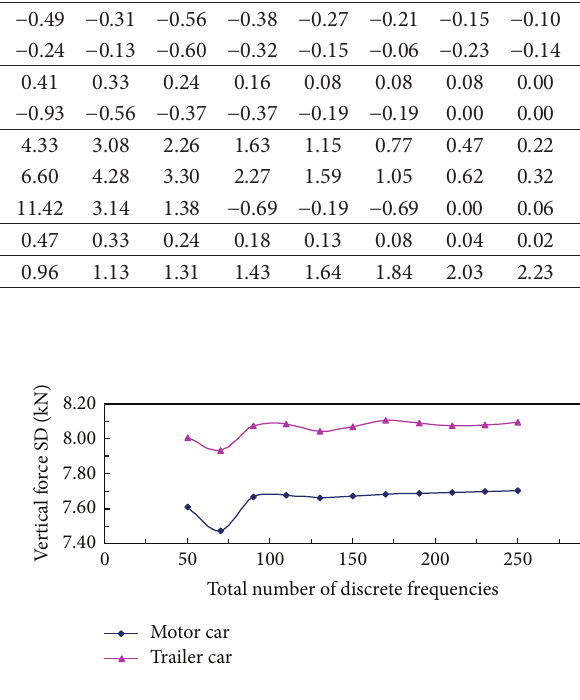
Figure 5: Maximum SD of wheel/rail vertical force.